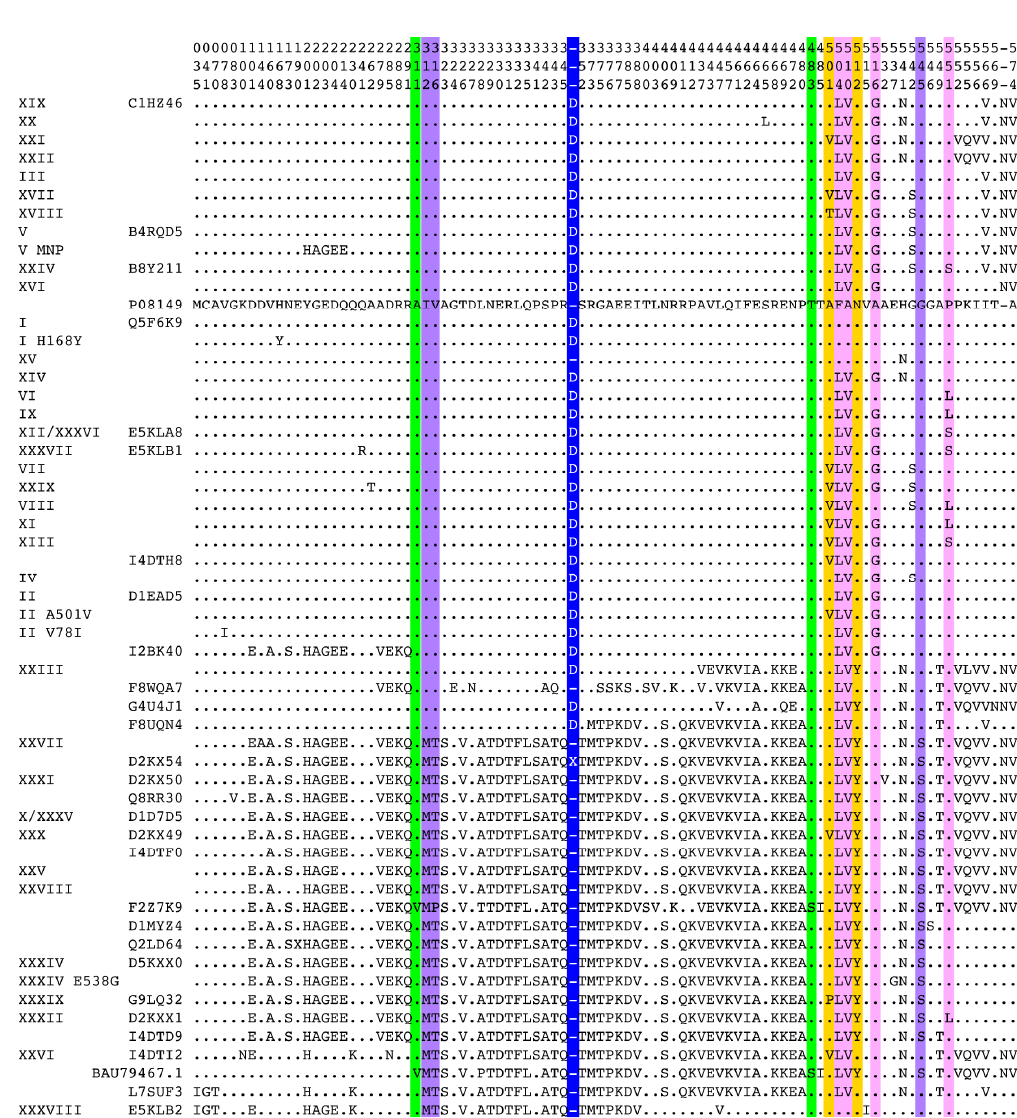
Figure 1. Alignment of PBP2 sequences from N . gonorrhoeae (aligned and clustered with CLUSTALW). The Roman numeral nomenclature and the Uniprot accession number are given on the left. Only positions where at least one sequence differs from the reference sequence from the susceptible strain LM306 [31] (Uniprot accession number #P08149) are shown. Substitutions or insertion shown experimentally to contribute to resistance are highlighted in color: blue [32,33]; pink [34,35]; violet [22]; yellow [34,36–38]; and green [39]. Yellow substitutions are specific to resistance to third generation cephalosporins. Green substitutions are responsible for high ‐ level resistance, including to third ‐ generation cephalosporins. This representation allows to clearly distinguish two types of sequences from resistant strains, either with the D346a insertion and few substitution clustered in the C ‐ terminal part, or without the D346a insertion with over 50 substitutions spanning the whole protein.